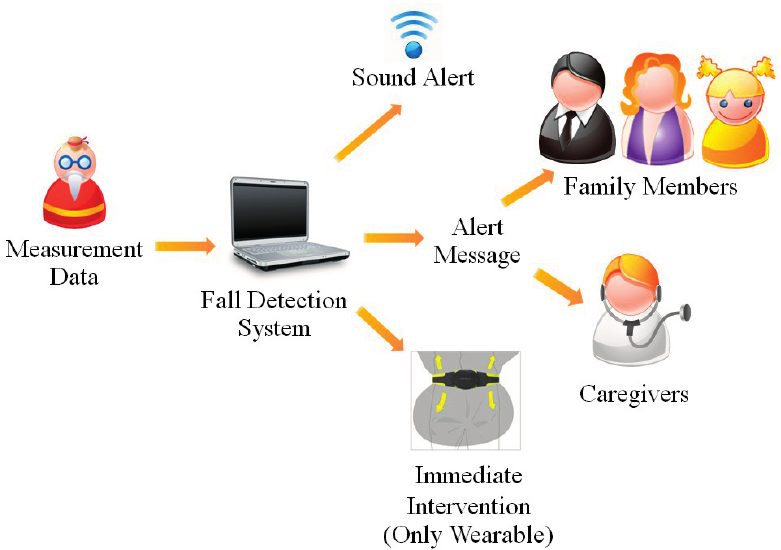
Figure 1. A system overview of a typical fall detection